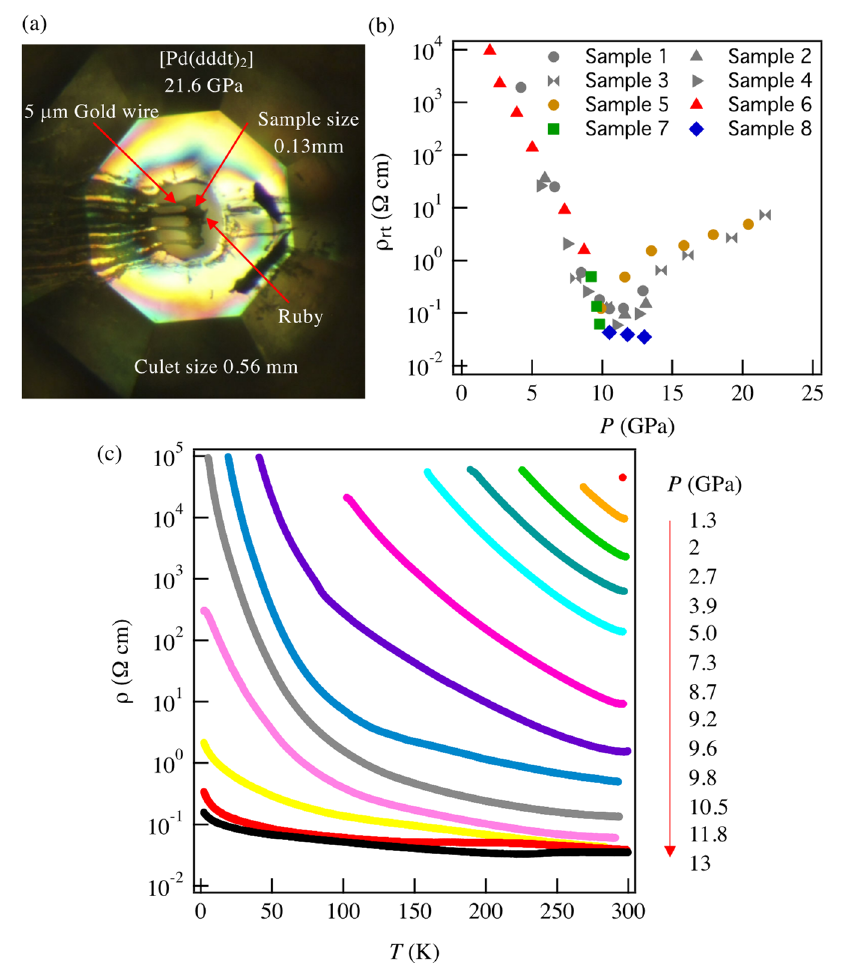
Figure 2. ( a ) Optical microscope image of the [Pd(dddt) 2 ] sample at 21.6 GPa assembled in a Diamond Anvil Cell (DAC). ( b ) The pressure dependence of room temperature resistivity (samples 1~4 = data from previous work [11]). ( c ) Temperature-dependent resistivity ρ under various pressures from 1.3 GPa to 13 GPa.